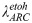
Sensitivity of ethanol production on the PhPP of S. stipitis.
λARCetoh: Sensitivity of qetoh to the Available Reducing Capacity (ARC). Planes are colored according to λARCetoh value, indicating if ARC is limiting (λARCetoh<0), is in excess (λARCetoh>0) or it has no effect on qetoh. (a) PhPP for the growth rate (μ) using glucose. (b) PhPP for the growth rate (μ) using xylose. (c) PhPP for the specific productivity of ethanol (qetoh) using xylose. (d) PhPP for the yield of ethanol from xylose (Yetoh).